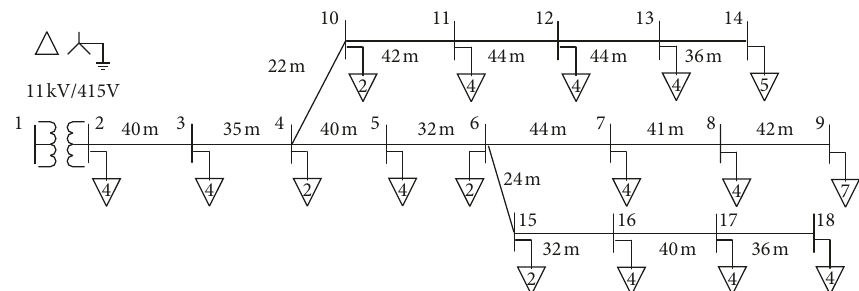
Figure 7: A typical 415V low-voltage distribution system with 64 customers.